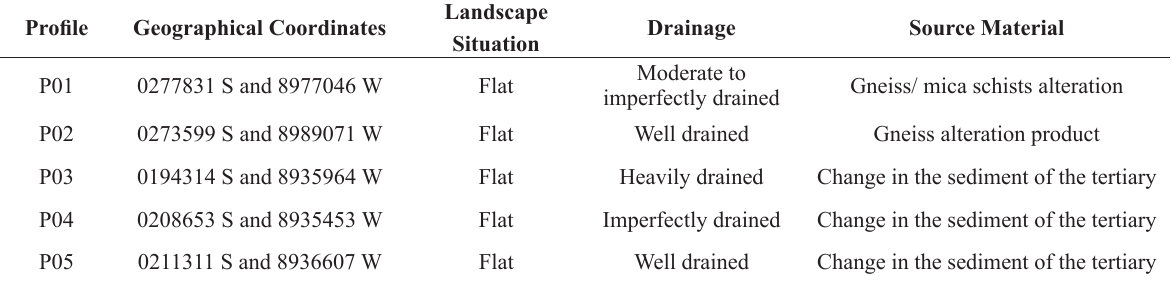
Profiles’ location, soil classification and physical environment